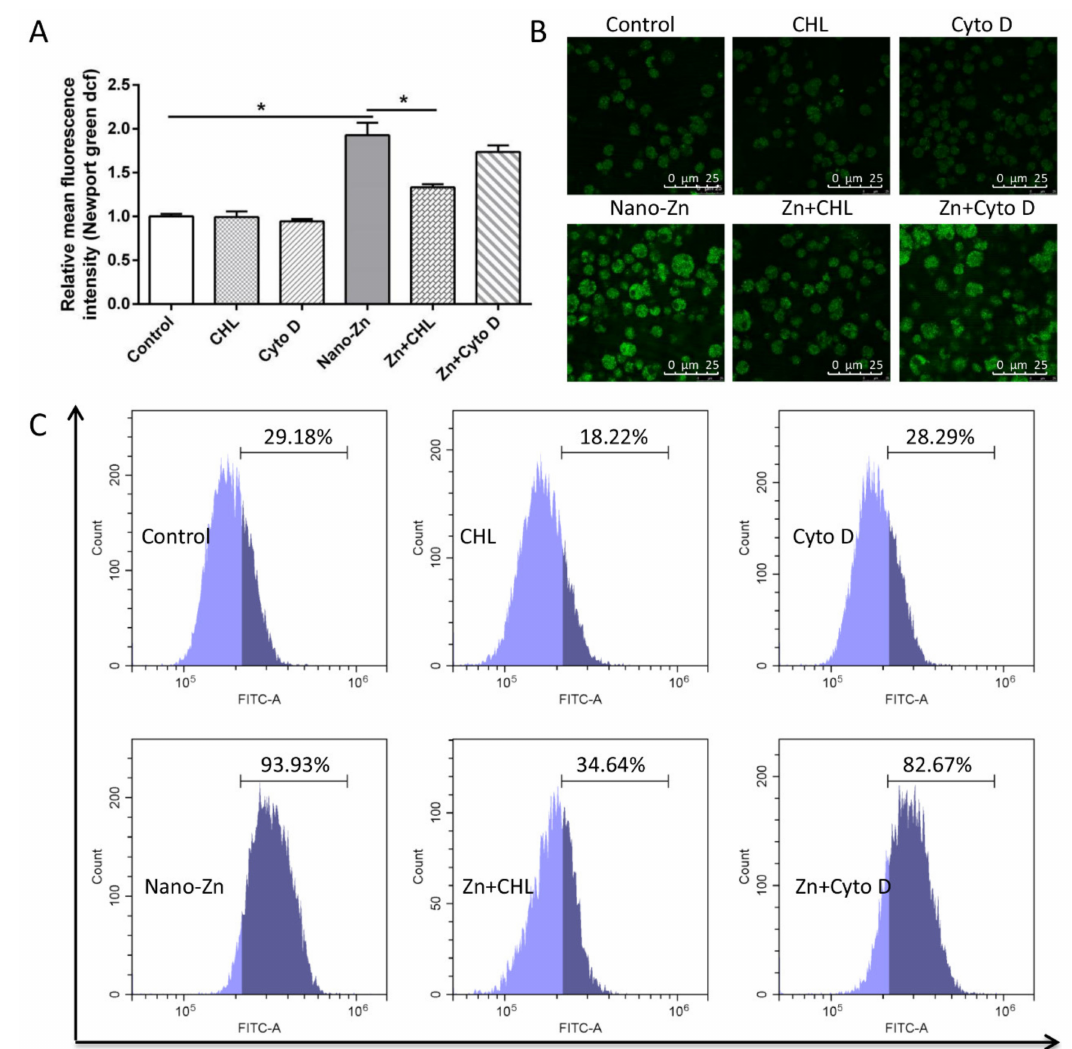
Figure 3. E ff ect of nano-Zn on clathrin pathway in intestinal epithelial cells. ( A ) Free Zn 2 + was quantified by calculating the FL1 (green) mean fluorescence intensity of intestinal epithelial cells incubated for 12 h in 40 µ M nano-Zn with 2 h of 10 µ g / mL CHL or 10 µ M cytochalasin D pretreatment. ( B ) Representative confocal microscopy stained with Zn 2 + fluorescent probe (Newport Green DCF). The primary intestinal epithelial cells from P. fulvidraco were incubated for 12 h in control or 40 µ M nano-Zn containing medium with or without 2 h of 10 µ g / mL CHL and 10 µ M cytochalasin D pretreatment. ( C ) The presence of DCF-stained Zn 2 + was demonstrated by flow cytometric analysis of green (FL1) fluorescence intensity. The primary intestinal epithelial cells from P. fulvidraco were incubated for 12 h in control or 40 µ M nano-Zn containing medium with or without 2 h of 10 µ g / mL CHL and 10 µ M cytochalasin D pretreatment. Values indicate means ± SEMs, n = 3–6. Asterisks ( ∗ ) indicate significant di ff erences between the two groups ( p < 0.05, n = 3). CHL, chlorpromazine; Cyto D, cytochalasin